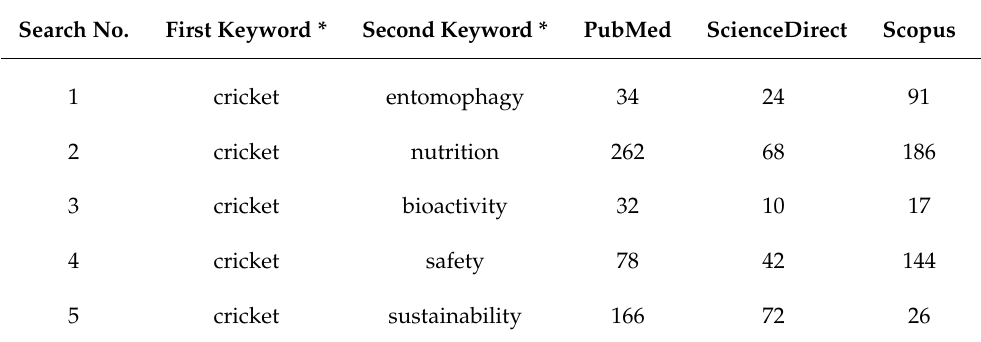
Table 1. Search strings and number of articles obtained from PubMed, ScienceDirect and Scopus until 2021. Search